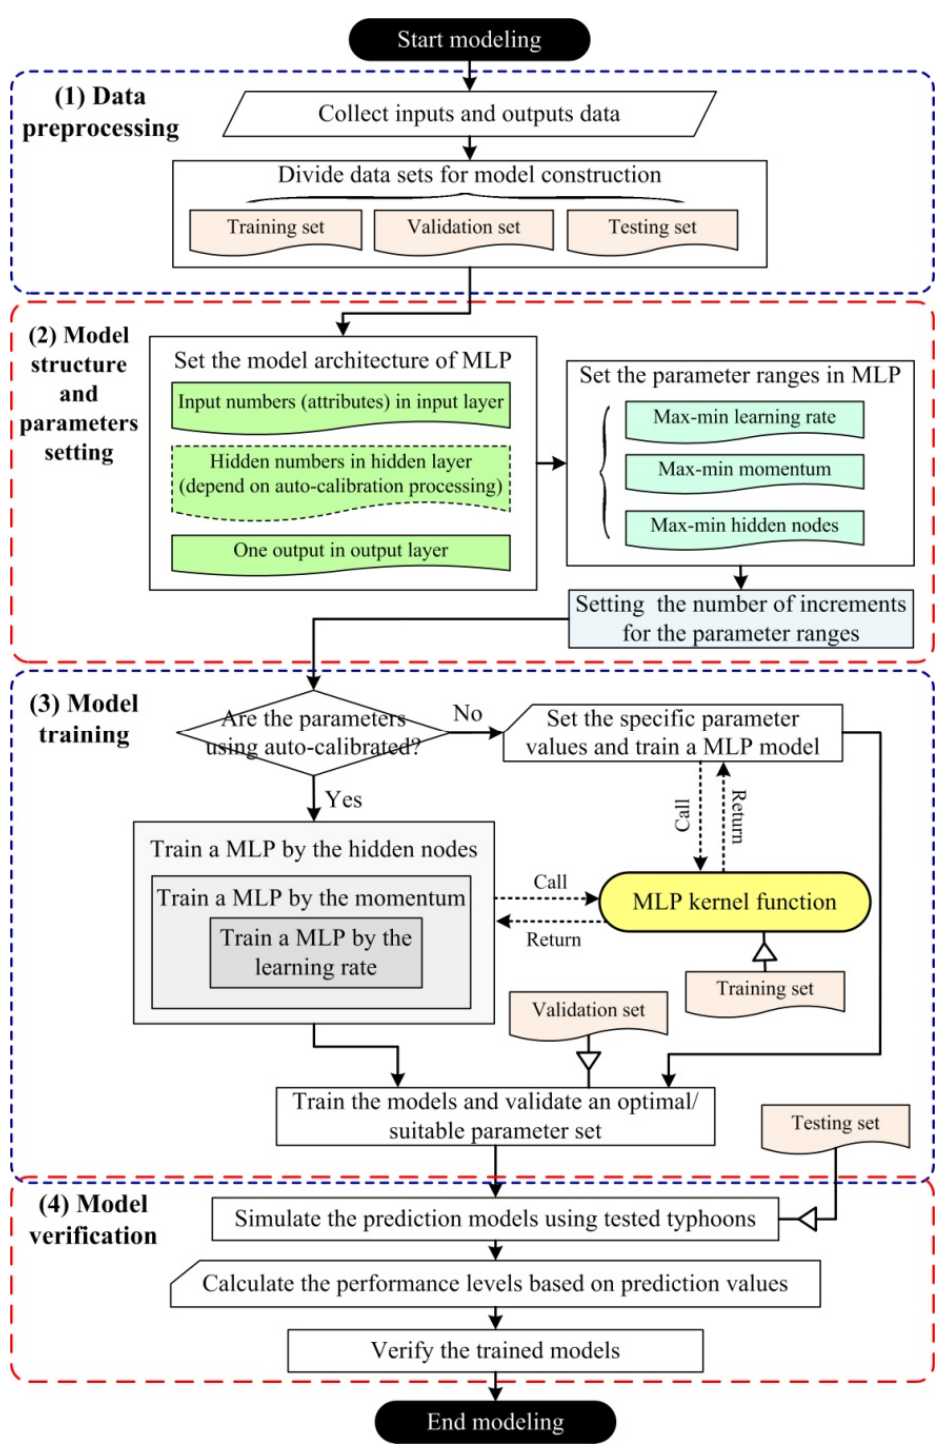
Figure 2. Determining artificial neural network (ANN)-based MLP parameters using an automatic calibration